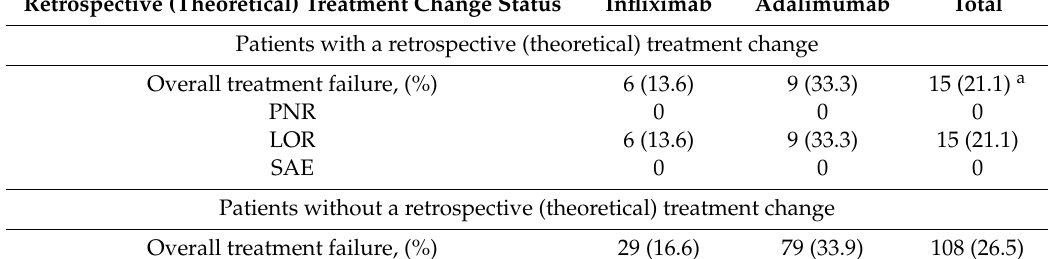
Table 3. Treatment failure per retrospectively determined (theoretical) therapeutic decision status. Retrospective (Theoretical) Treatment Change Status